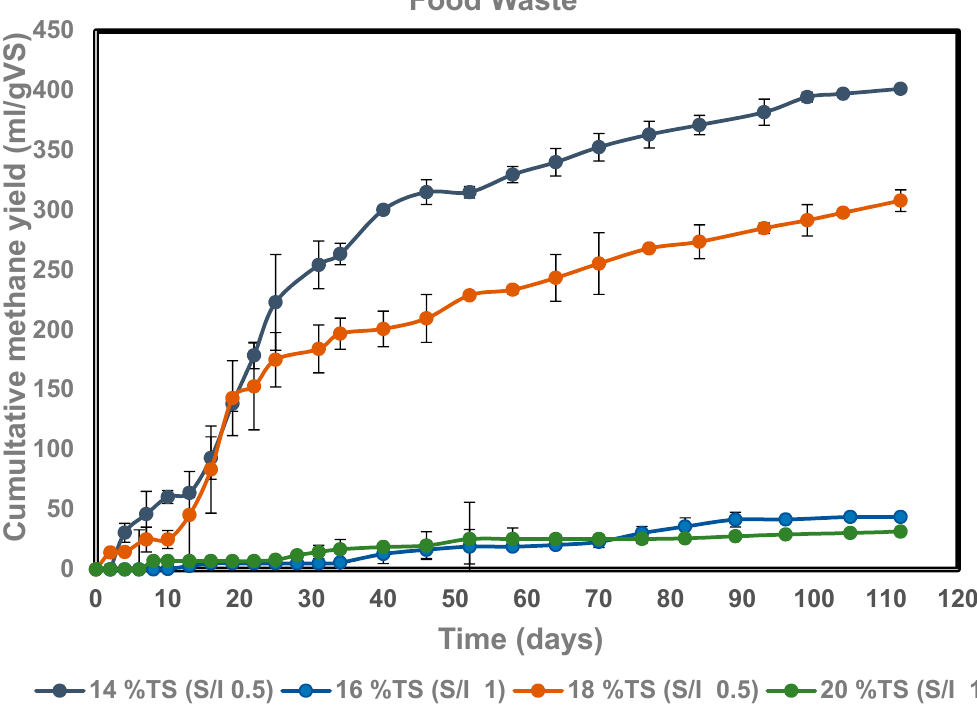
Figure 2. Cumulative methane yield of food wastes at different total solid (TS) concentrations of the mixture in reactors at substrate to inoculum ratios (S/I) of 0.5 and 1.